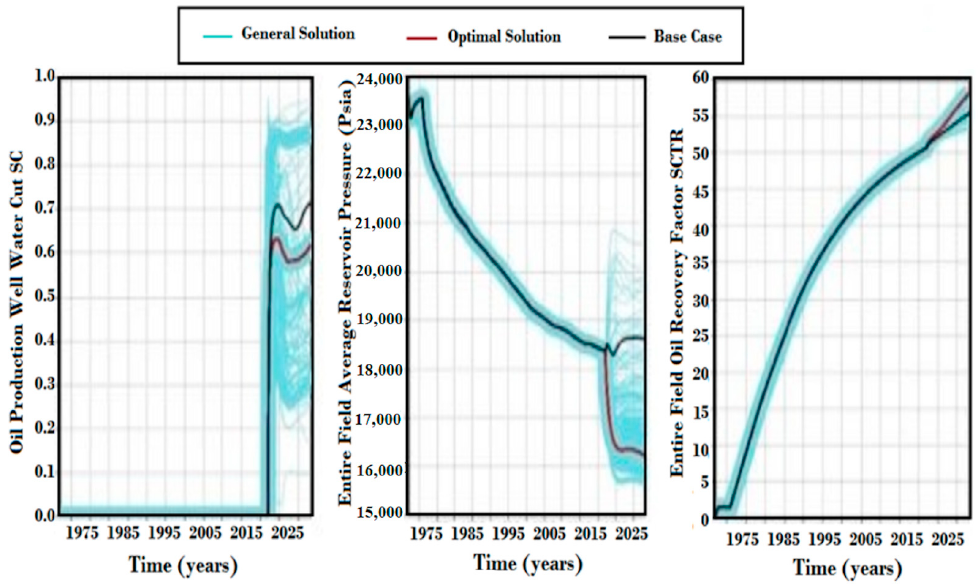
Figure 11. PSO optimal flow responses for the five hundred simulation cases evaluated. Left: oil well water cut; middle: average reservoir pressure; and right: oil recovery factor.